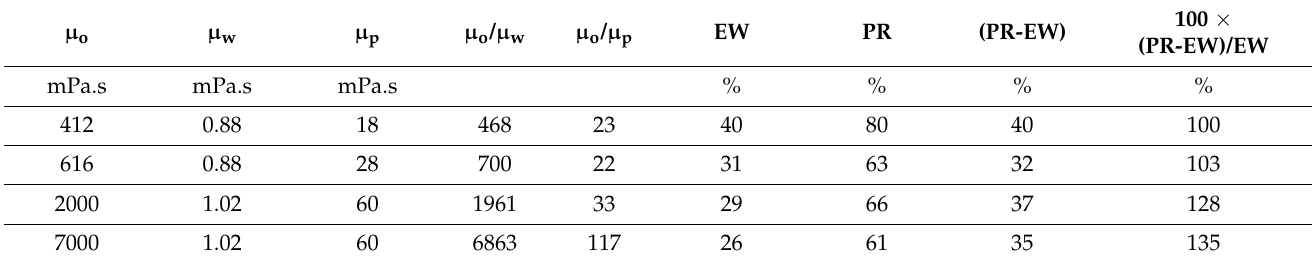
Table 2. Summary of experimental